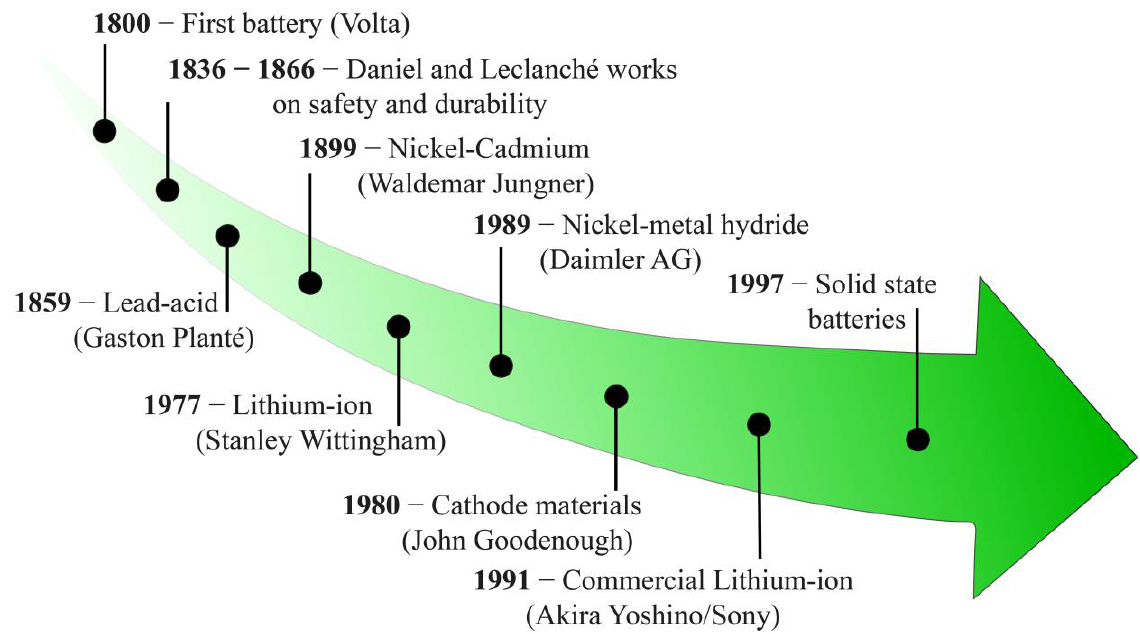
Figure 1. Advances in battery system development over the years.